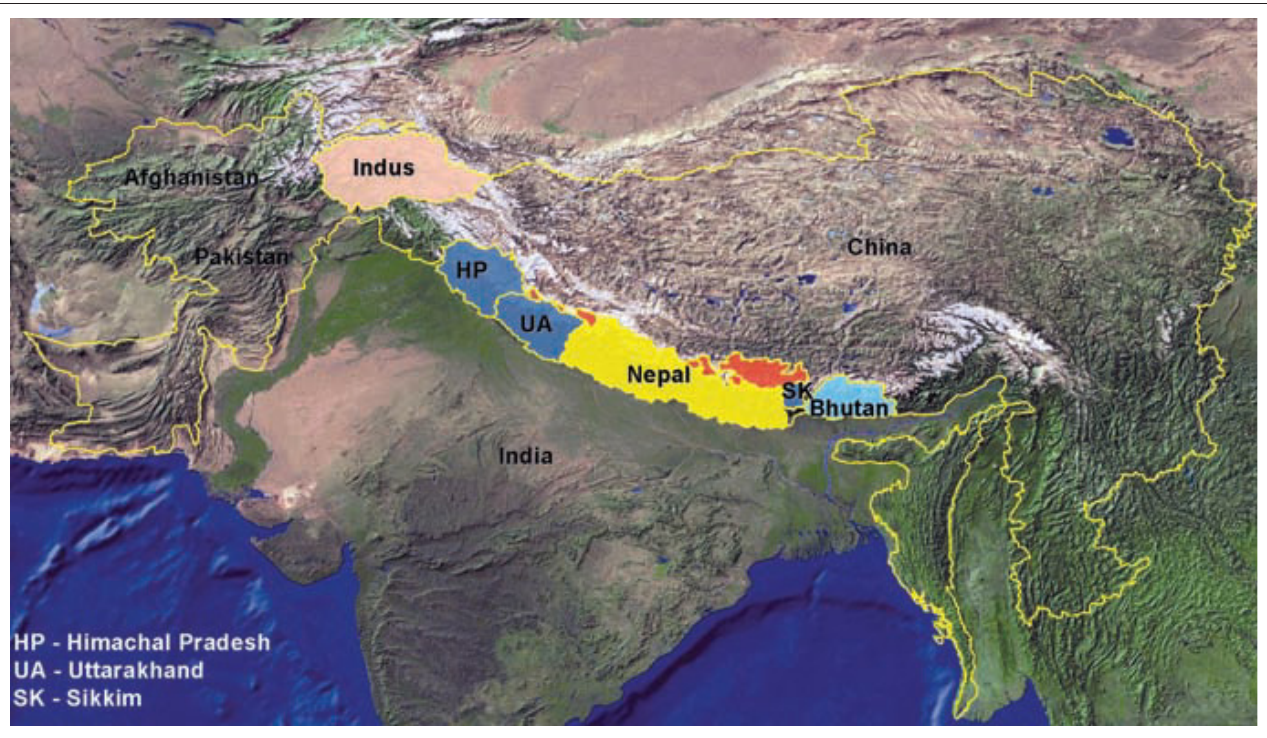
FIGURE 1: Map of the glacial bodies (in colour) along the Himalayan belt, with Indus shown as the river system originating in the Himalayas. frequent and posing a greater risk of potential losses to the Himalayan terrain.